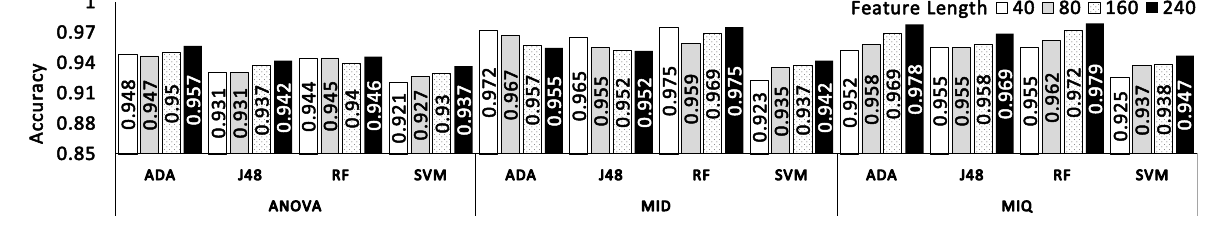
Figure 9. Performance of feature